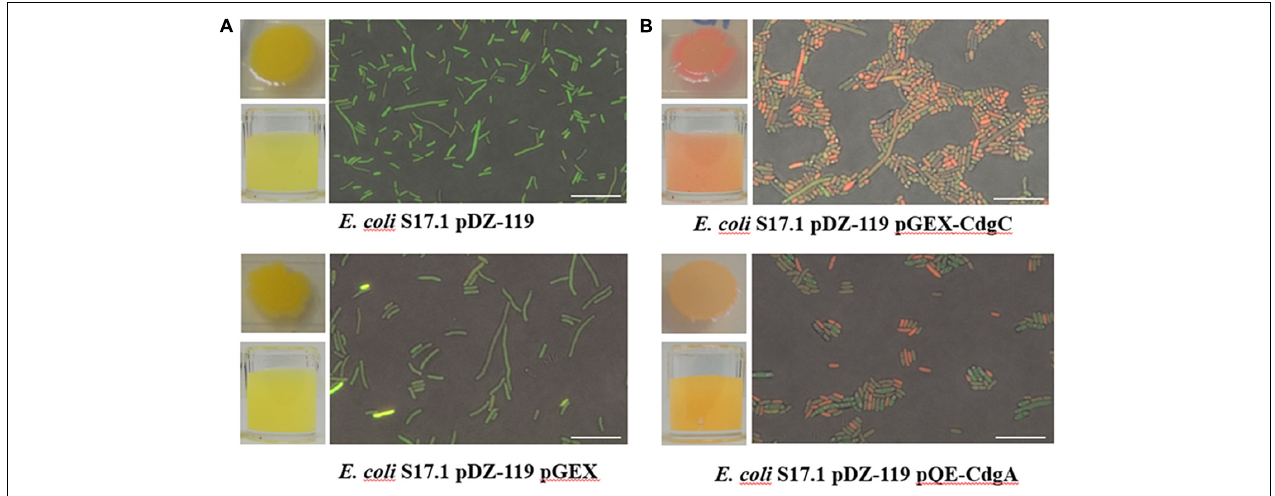
FIGURE 4 | c-di-GMP accumulation assay using a specific biosensor. Representative images of visible fluorescence of concentrated cultures and microscopic fluorescence detection in individual cells in (A) control strains E. coli S17.1 pDZ-119 and E. coli S17.1 pDZ-119/pGEX; (B) strains overproducing CdgC or CdgA. The microscopic assessment of c-di-GMP levels was performed using a Nikon Eclipse TE2000-U fluorescence microscope. The excitation and emission of the AmCyan fluorophore were recorded at 489 and 519 nm, respectively. The TurboRFP fluorophore was excited at 553 nm, and emission was measured at 574 nm. Images obtained were edited with Nikon NIS Elements software. Bar 10 µ m. The data presented are representative of three independent experiments.